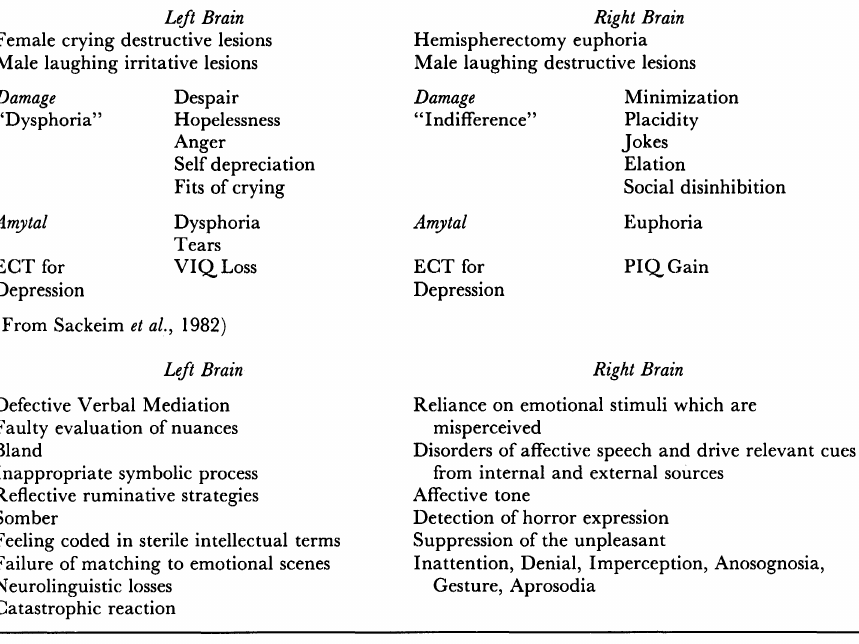
Emotional and psychological iffects of lateralized brain damage-composite accounts Lift Brain Female crying destructive